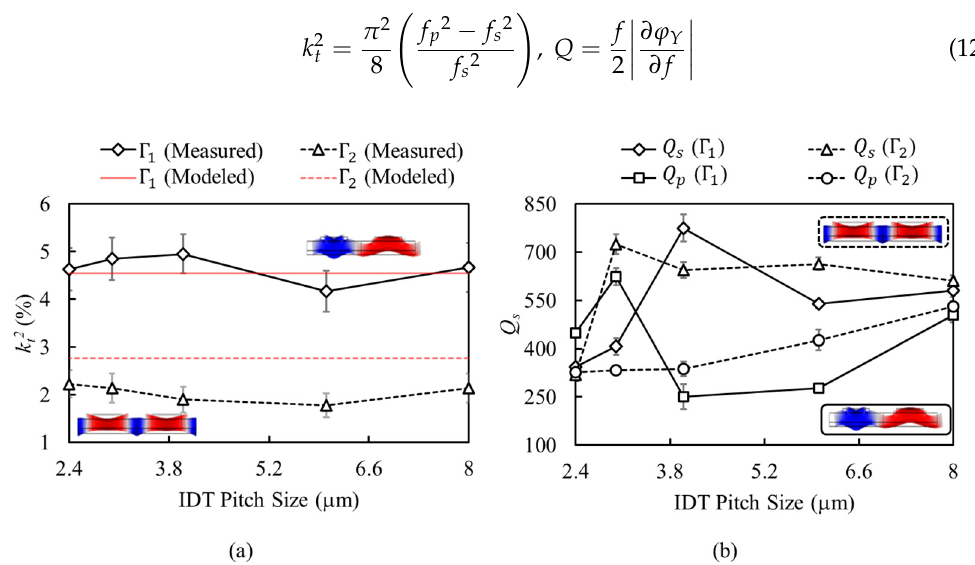
Figure 8. ( a ) Measured k 2 of the two modes for resonators with different IDT pitch sizes, in compar- ison with values extracted from analytical model. ( b ) Measured Q s and Q p of the two modes, for resonators with different IDT pitch sizes. For each IDT pitch size, the k 2 , Q s , and Q p are the average of values measured from ten resonators across the 4-inch substrate.